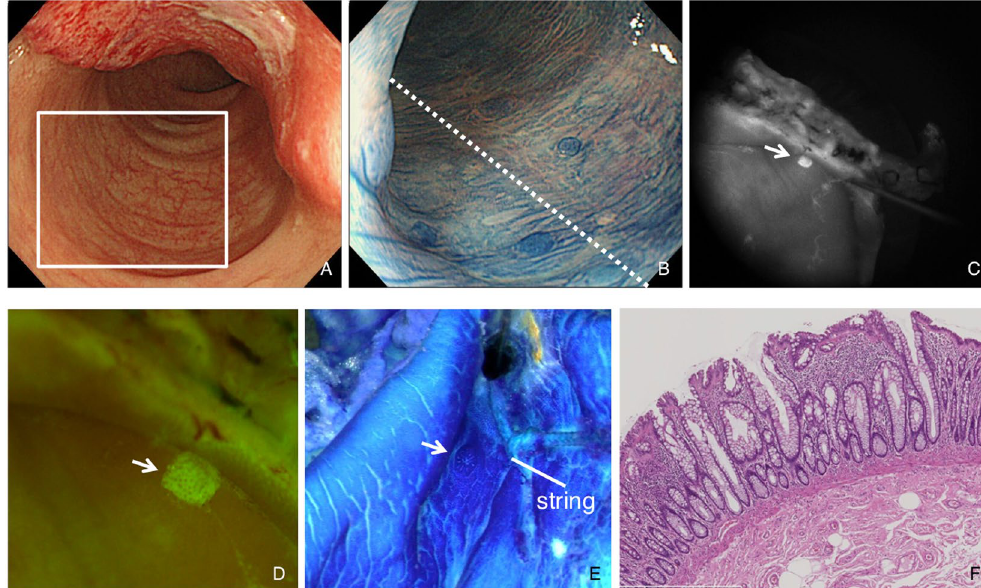
Figure 5. Ex vivo molecular imaging of ACF in human resected colorectum. A colonoscopy was performed in a patient with colorectal cancer (CRC) by using a high-definition magnification colonoscope. ( A ) White light finding for CRC. The squared area corresponds to Panel B. ( B ) ACF identified by methylene blue staining with magnifying observation. After surgical resection, the colon was cut along the dotted line. ( C ) An ACF identified in surgically resected colon after DNAT-Me application with fluorescence imaging (arrow). ( D ) A pseudocolored image of the ACF in Panel C (arrow). ( E ) An ACF observed in formalin-fixed colon observed under a stereomicroscope after methylene blue staining (arrow). Mucosa adjacent to the ACF was marked with a string suture. ( F ) Histological findings for the